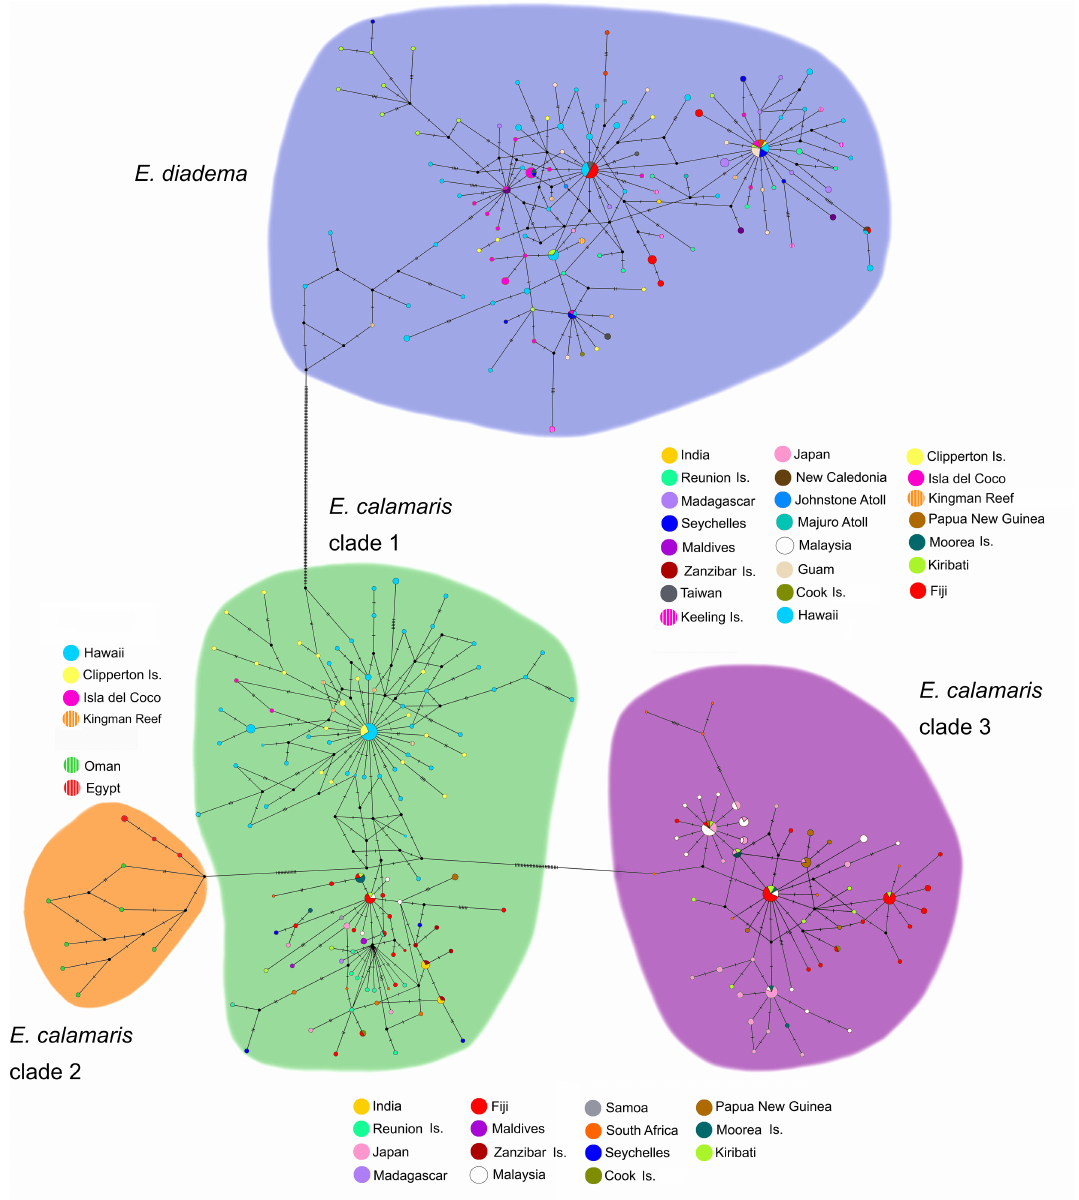
Figure 4. Median joining haplotype network based on mitochondrial ATPase6, ATPase8 and 16S. Constructed in PopART with reticulation tolerance set to